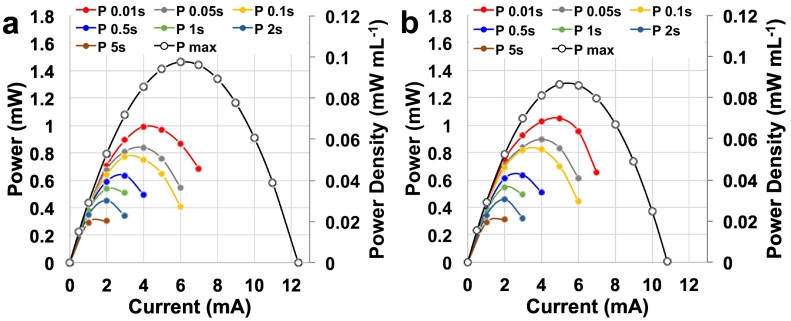
Ppulse for MFC-A (a) and MFC-B (b) for tpulse of 0.01 s, 0.05 s, 0.1 s, 0.5 s, 1 s, 2 s and 5 s.